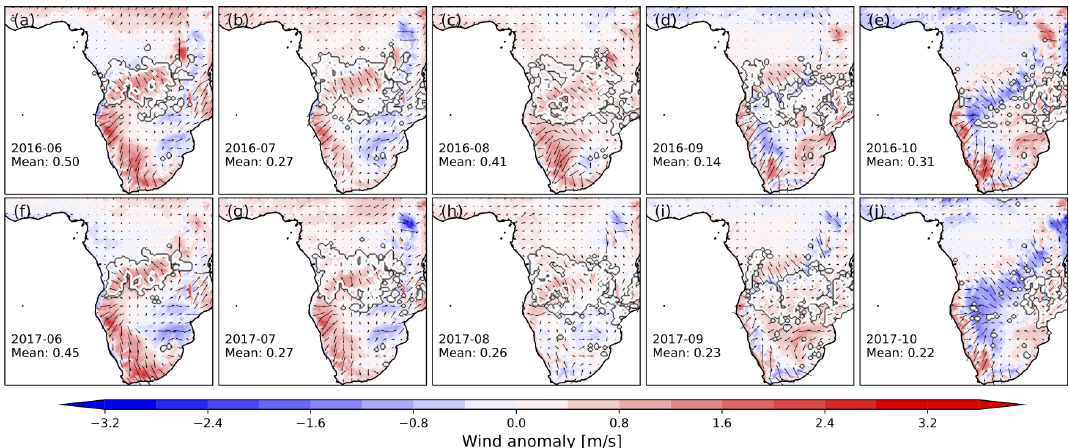
Figure 11. Monthly mean surface wind anomaly calculated from the ERA5 reanalysis data. The baseline is an average from June to October in 2016 and 2017 combined. The means are calculated as the average anomalies in the major burning areas ( > 500 fire counts), which are illustrated in the black counter each